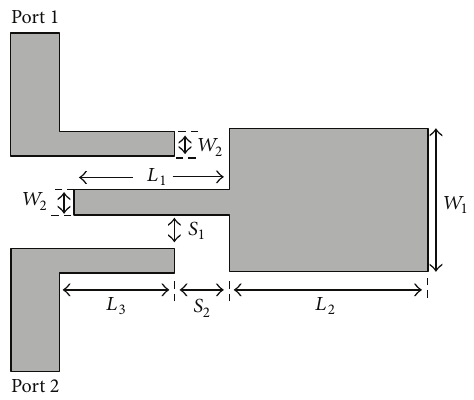
Figure 13: Structure and model of the broadband band-pass filter presented in [2].